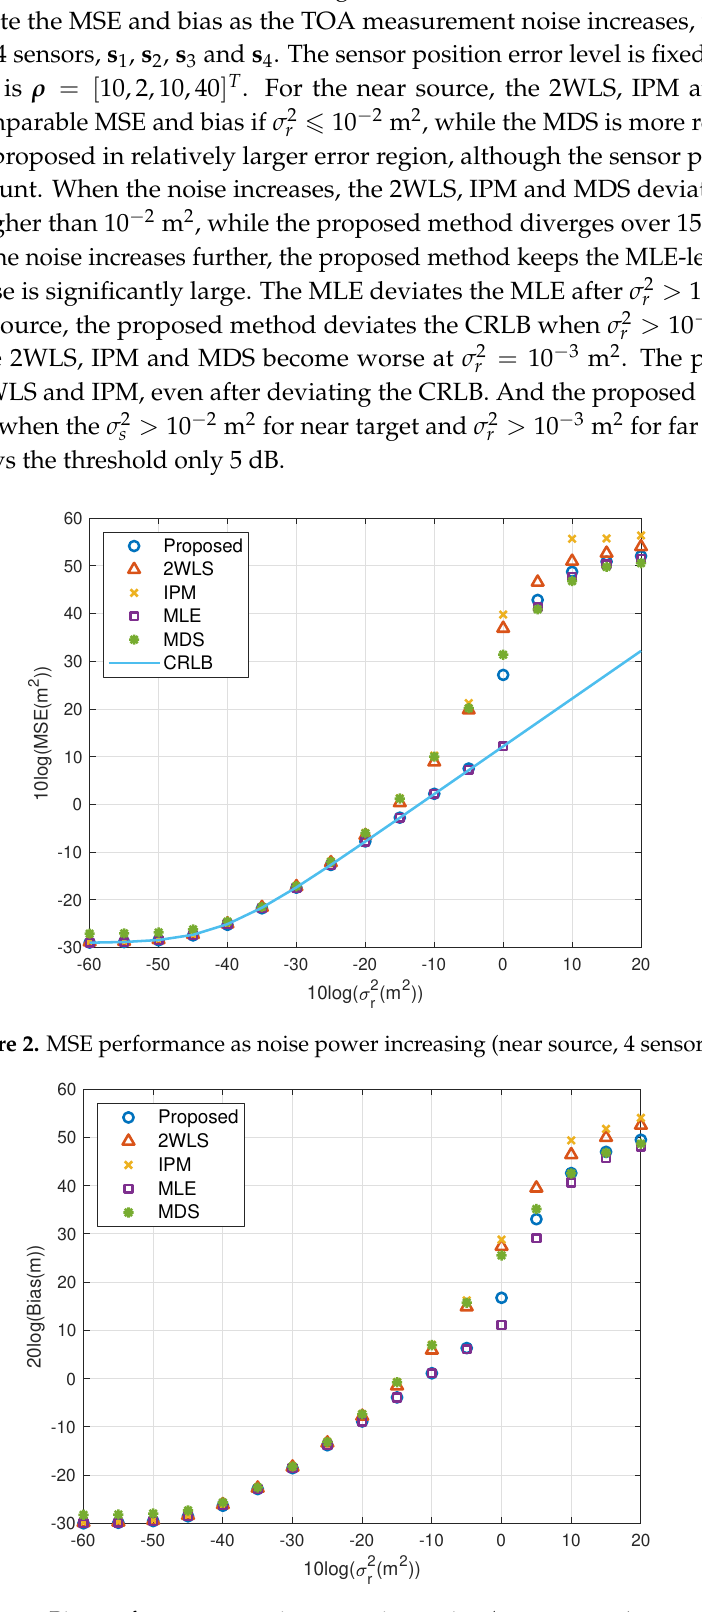
Figure 3. Bias performance as noise power increasing (near source, 4